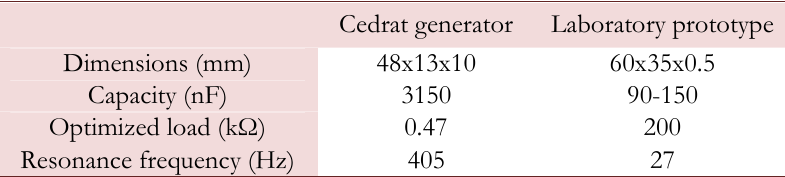
Table 2: Some properties of the two piezoelectric generators.